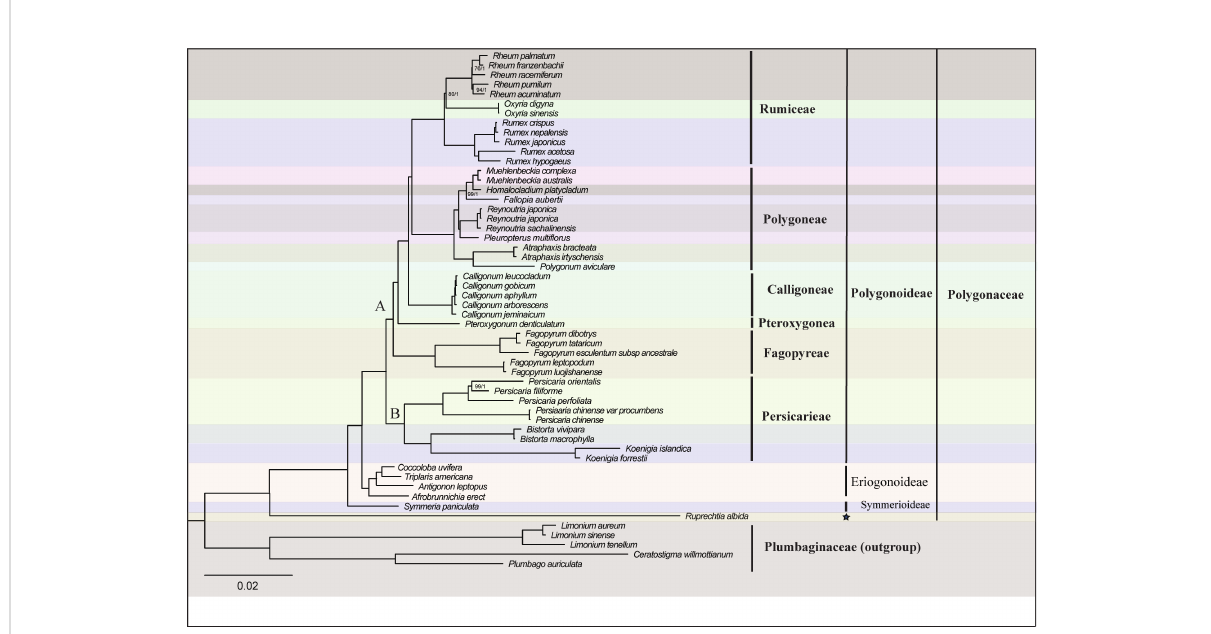
FIGURE 2 Phylogenetic tree of 54 taxa using maximum likelihood (ML) and Bayesian inference (BI) based on 74 shared genes. Maximum likelihood bootstrap values (BS) and posterior probabilities (PP) are shown at nodes. Branches with no values listed have 100% BS and PP of 1.0. Pentagram represents uncertain classi fi cation treatment.